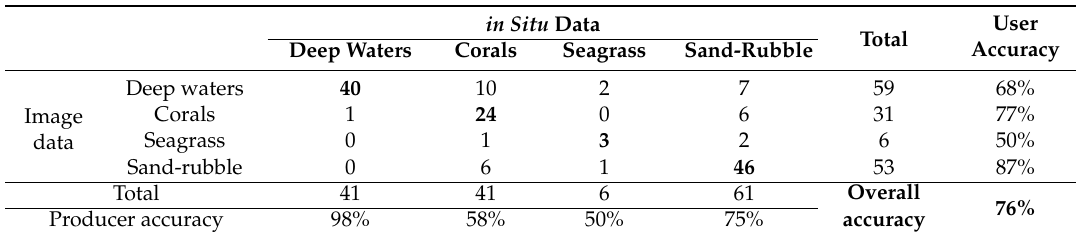
Table 1. Confusion matrix and accuracies for water targets (deep waters and three substrate types: corals, seagrass and